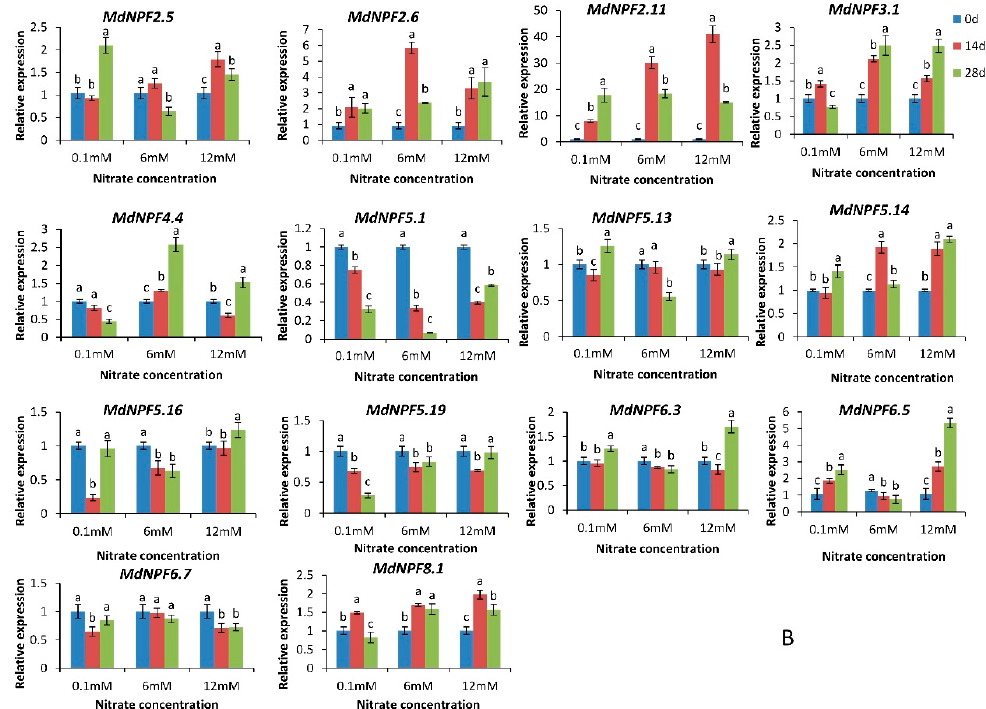
Figure 6. Relative expression levels for 14 cloned apple NPF s under different nitrate concentrations, calculated by 2 − ∆∆ C t method with respect to control samples (i.e., 6 mM NO 3 − ): ( A ) the relative expression levels for 14 cloned apple NPF s of roots under different nitrate concentrations; and ( B ) the relative expression levels for 14 cloned apple NPF s of leaves under different nitrate concentrations. Different letters on the bars within a group indicate significant differences ( p < 0.05), based on Tukey’s multiple range tests.